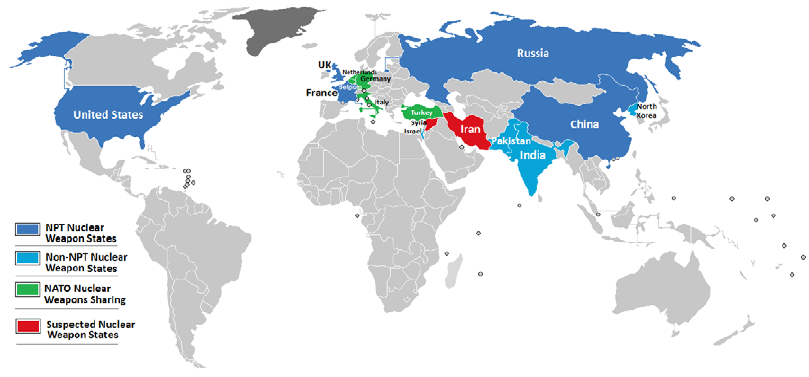
Figure 1. Map of countries with nuclear weapons. NPT, nuclear nonproliferation treaty. Source: http://commons.wikimedia.org/wiki/File:Nuclear_weapons.png.